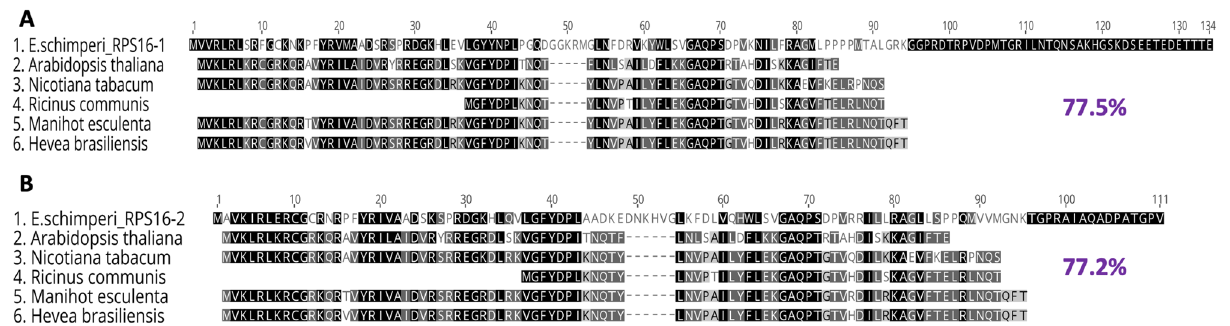
Figure 3. ( A ) Alignments of nuclear RPS16-1 of Euphorbia schimperi and plastid RPS16 of other Euphorbiaceae ( Manihot esculenta, Hevea brasiliensis, Ricinus communis), Arabidopsis thaliana and Nicotiana tabacum . ( B ) Alignments of nuclear RPS16-2 of Euphorbia schimperi and plastid RPS16 of other Euphorbiaceae ( Manihot esculenta, Hevea brasiliensis, Ricinus communis ) , Arabidopsis thaliana and Nicotiana tabacum . Pairwise aa sequence identity of the two E. schimperi transcripts (RPS16-1 and RPS16-2) with other Euphorbiaceae, Arabidopsis thaliana and Nicotiana tabacum was 77.5% and 77.2%, respectively. Gaps are indicated by of multiple species of Malpighiales including Euphorbiaceae [ Manihot esculenta (81%), Hevea brasiliensis (80%), Jatropha curcas (85%)], Passifloraceae [ Passiflora oerstedii (62%)] and Salicaceae [ Populus trichocarpa (76%), P. alba (76%) and P. euphratica (62%)]. A nuclear-encoded copy of infA was not found in the transcriptome of E. schimperi . Phylogenetic distribution of rpl32 and rps16 gene losses/transfers/substitutions in Malpighi- ales. The phylogenetic analysis that included 45 protein-coding plastid genes was performed to generate a tree for plotting the distribution of rpl32 and rps16 gene losses/transfers or substitutions across Malpighiales